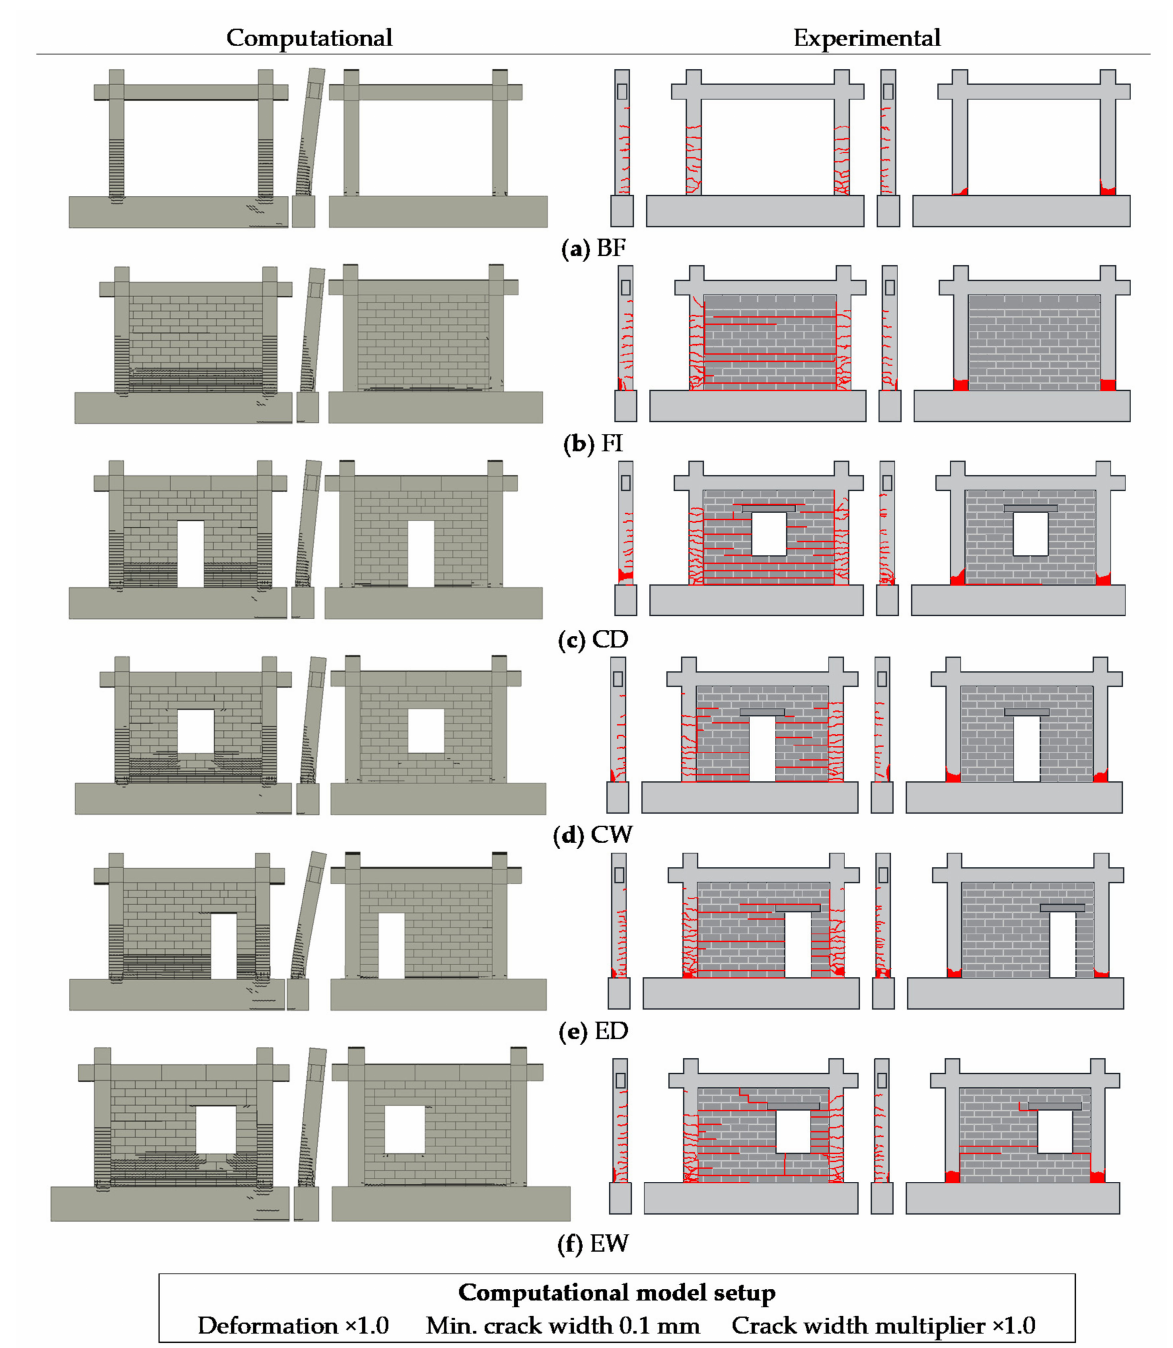
Figure 25. Crack patterns of OoP cyclic, quasi-static load (@ d r ∼ = 10%). ( a ) BF; ( b ) FI; ( c ) CD; ( d ) CW; ( e ) ED; ( f )